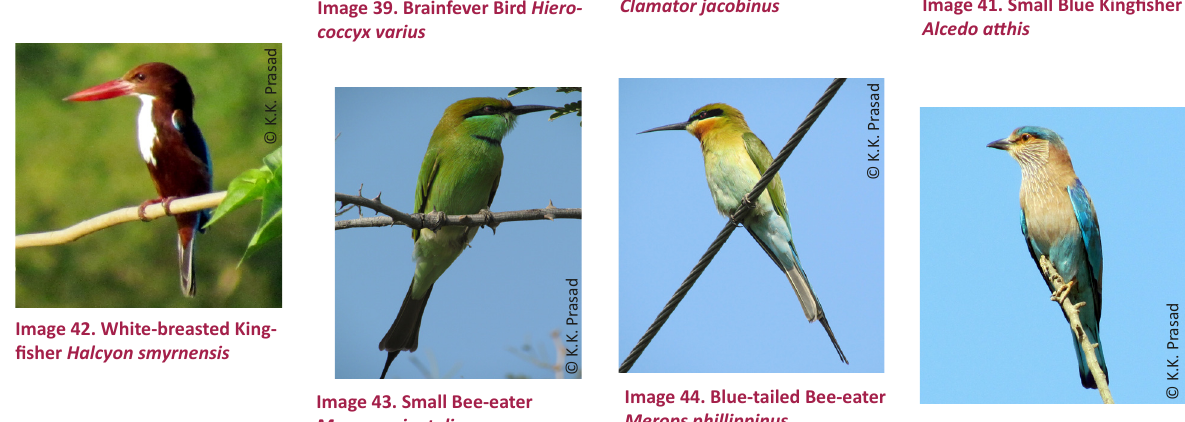
Image 45. Indian Roller Cora- cias benghalensis